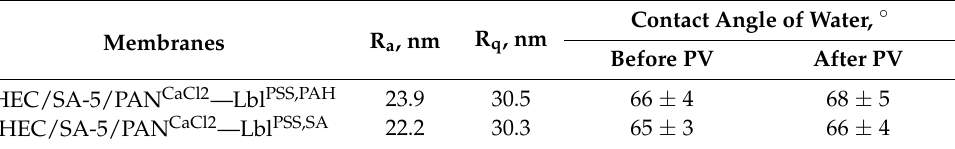
Table 7. Surface parameters and contact angle of water before and after pervaporation (PV) for the HEC/SA-5/PAN CaCl2 —Lbl PSS,PAH and HEC/SA-5/PAN CaCl2 —Lbl PSS,SA membranes. Contact Angle of Water, ◦ Membranes R a , nm R q , nm Before PV After PV HEC/SA-5/PAN CaCl2 —Lbl PSS,PAH 23.9 30.5 66 ± 4 68 ± 5 HEC/SA-5/PAN CaCl2 —Lbl PSS,SA 22.2 30.3 65 ± 3 66 ±